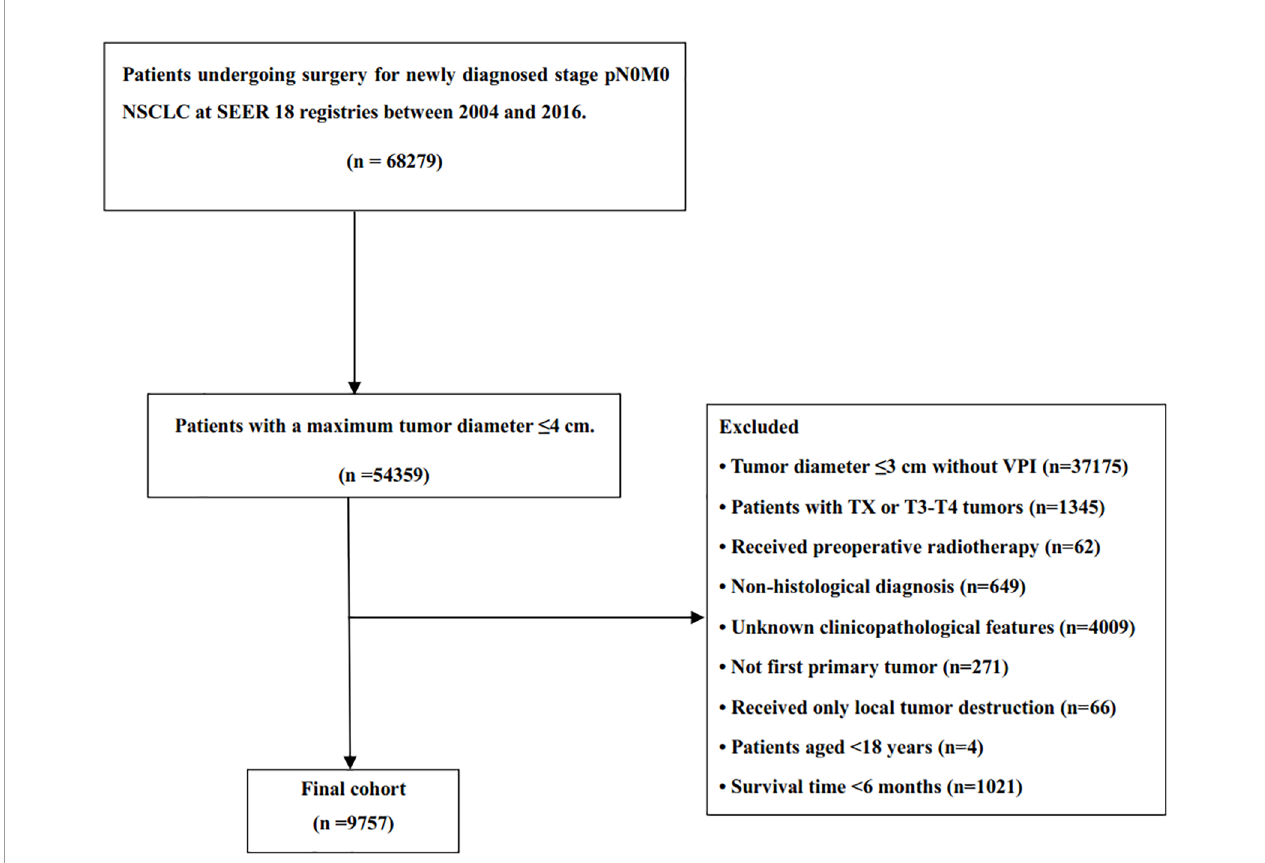
FIGURE 1 | Consort diagram of patient selection from SEER